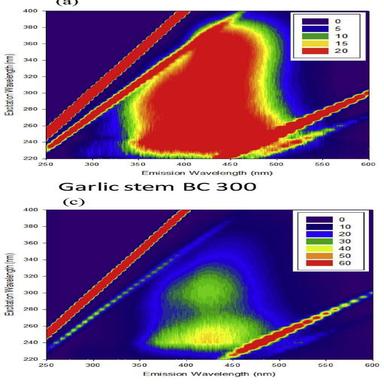
Fluorescence EEMs of biochar samples. (a) Garlic stem BC300 (300 °C), (b) Steam activated tea waste biochar BC700 (700 °C), (c) Perilla BC700 (700 °C).